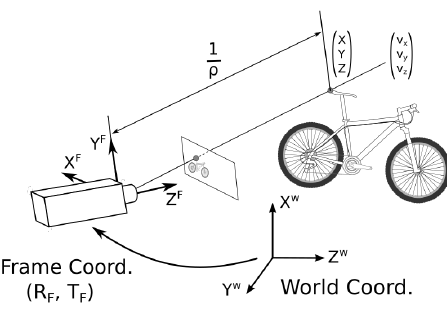
Figure 2. 3D points parameterization and translation to Euclidean coordinates.